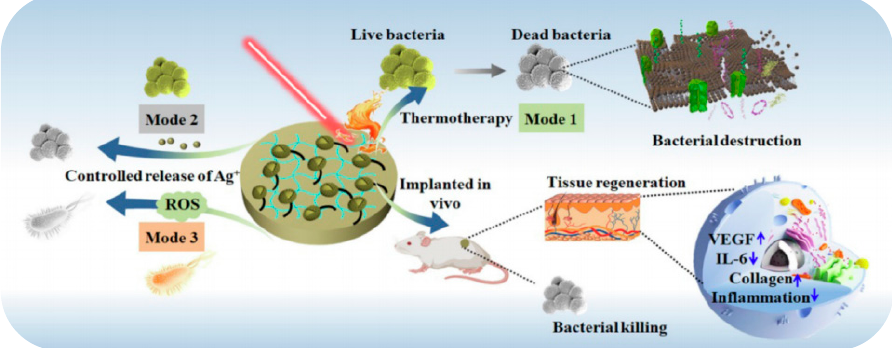
Figure 7. Composite hydrogel for antibacterial treatment [130].